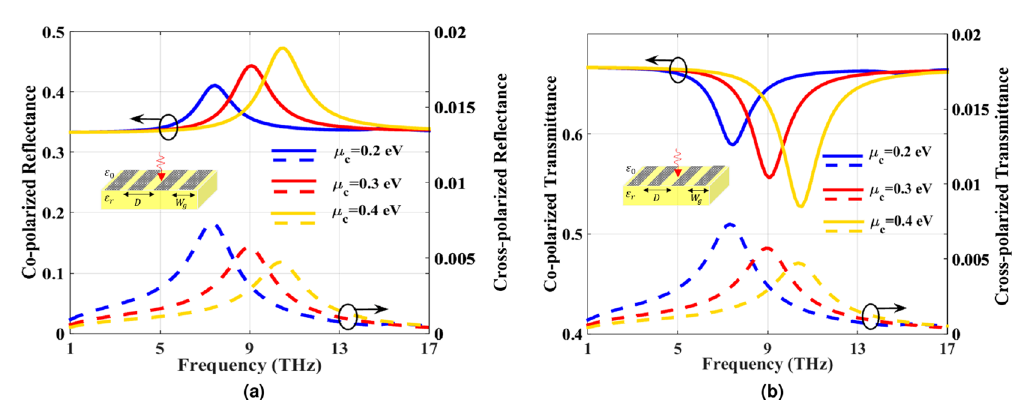
Figure 9. Co- and cross- ( a ) reflectance ( b ) and transmittance at different chemical potentials for B 0 = 1 T, τ = 0.1 ps and T = 300